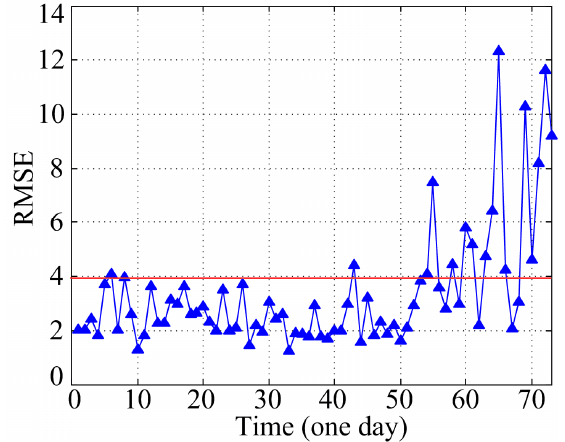
Figure 17. RMSE over one day of model for the temperature of generator bearing